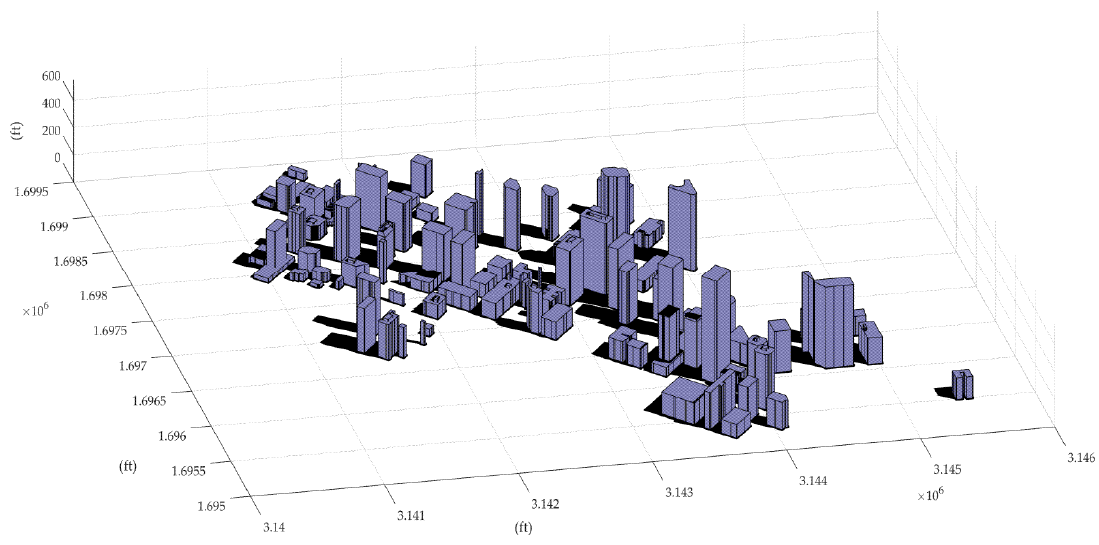
Figure 13. The result of final detection through DBM.